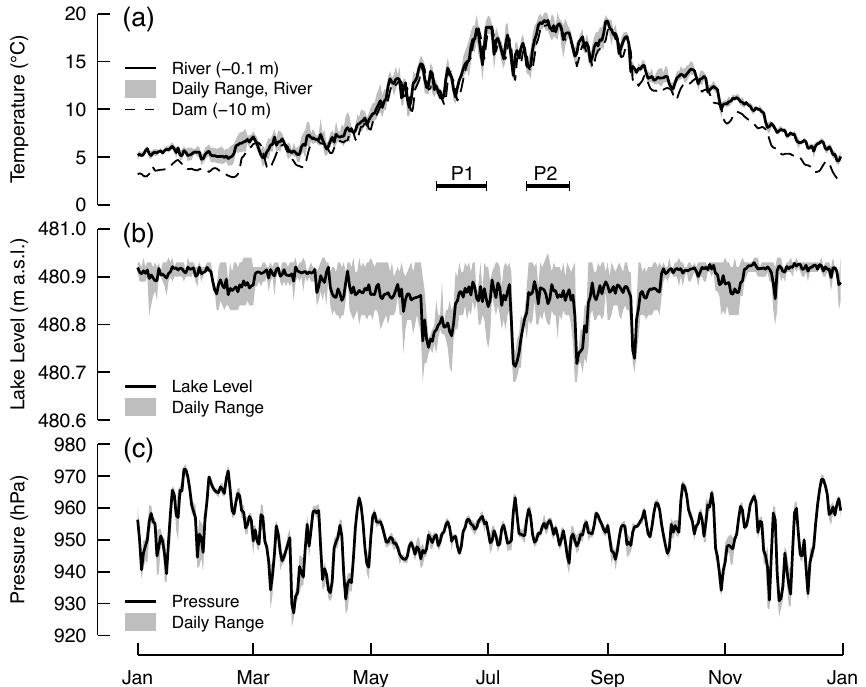
Fig. 4. Driving variables of CH 4 efflux from lake Wohlensee at daily resolution, (a) temperature of the river waters (0.1m; bold line with gray band showing daily range of values) and the dam (10m, dashed line); (b) lake level measured at the dam (bold line with gray band showing daily range of values); and (c) atmospheric pressure (bold line with gray band showing daily range of values). Data courtesy of Swiss Federal Office for the Environment ( a , river temperature), Bernische Kraftwerke BKW ( a , dam temperature, and b ), and MeteoSwiss (c) . P1 and P2 indicate the period when eddy covariance flux measurements were carried out.